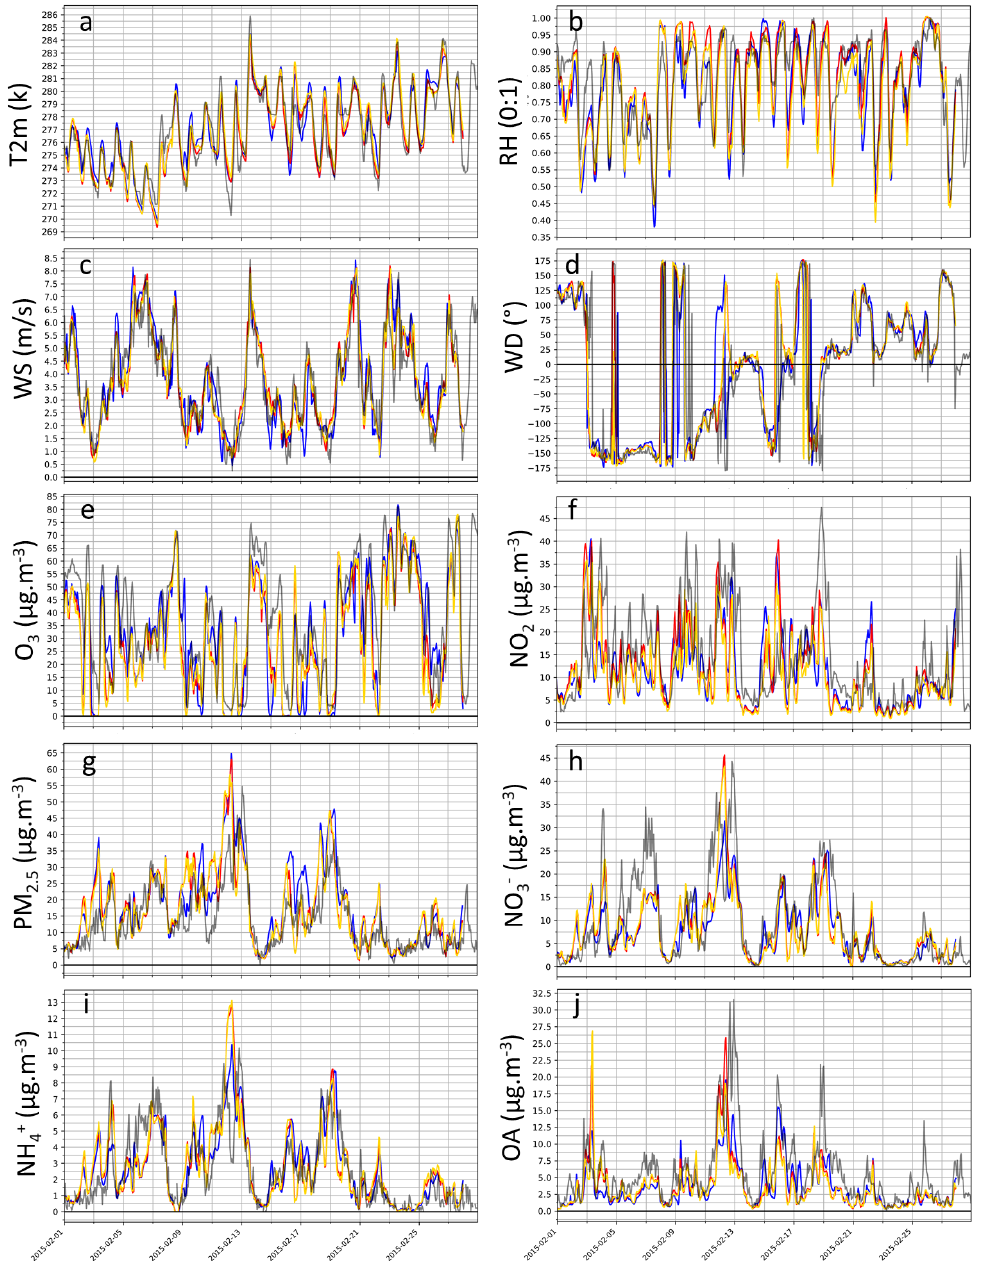
Figure 2. Time series for meteorological variables and surface concentrations. Data are averaged for all stations included in the PAR03 domain and for each corresponding cell of the modeled domains (PAR03, PAR10 and FAIR30). The name and the unit for each variable/species is written on the left side of each plot. Simulations for FAIR30 are shown in blue, PAR10 in red and PAR03 in gold. Statistics for these species/variables are shown in Tables 2 and 3. Panels ( a – d ) show temperature (T2M), relative humidity (RH), wind speed (WS) and wind direction (WD) respectively.Panels ( e , f ) show ozone (O 3 ) and nitrogen dioxide (NO 2 ) while panels ( g – j ) show PM 2.5 , nitrates (NO − organic aerosols (OA)